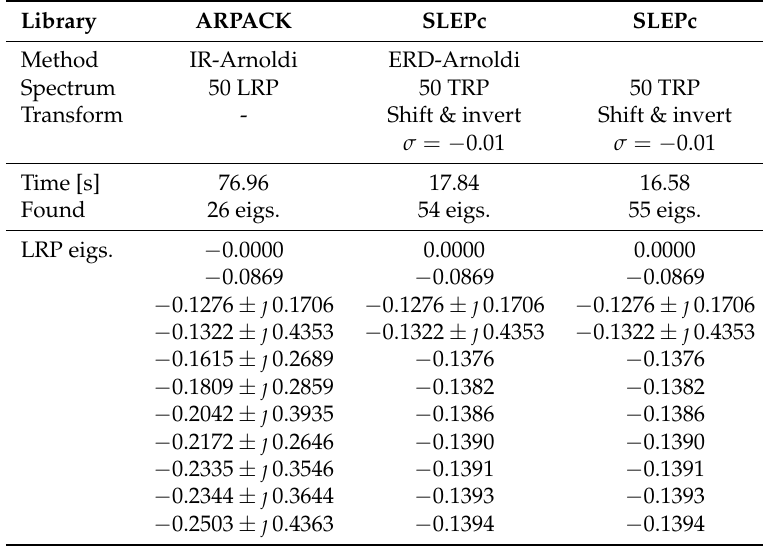
Table 9. AIITS: Krylov subspace methods,